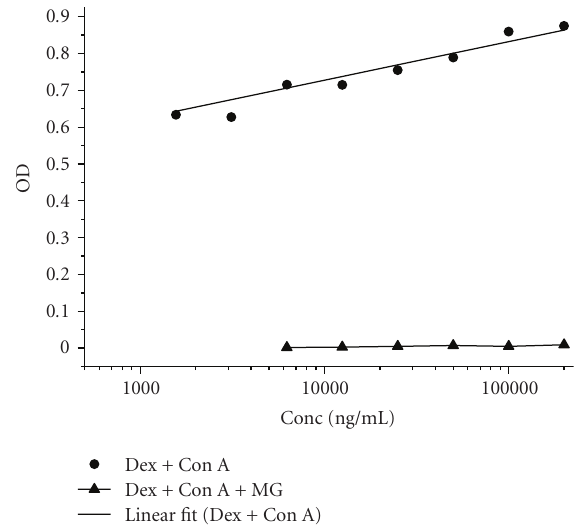
• Figure 2: Lectin assay: calibration curve of dextran detected by Con A (regression line as linear fit), (cid:2) inhibition of Con A with α - methylglucoside (MG) prior to dextran